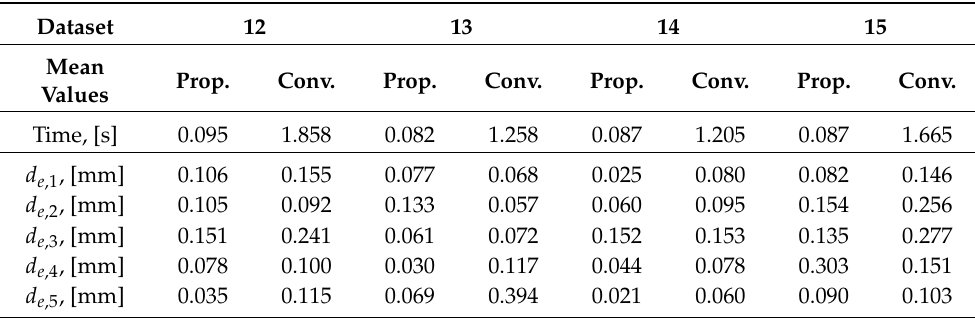
Figure 25. Parametrization results with groove corner points for datasets 12 (to the left) and 13 (to the right). The red dots show the result from the proposed procedure and the black dots show results from the conventional RANSAC. The grey points have been identified as noise by the noise detection algorithm. Table 6. Comparison of the results using datasets 12–15. The fit error definition is given in the beginning of Section